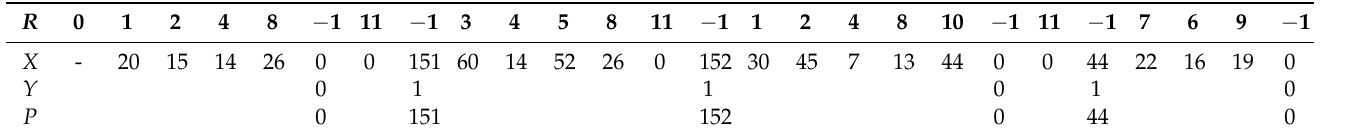
Table 12. Correction for i = 7 in C.